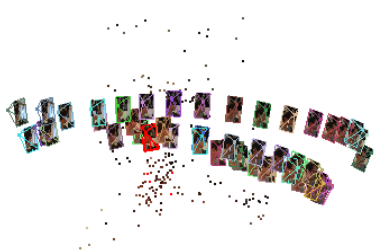
Figure 6. Imaging geometry of the first test case. Images were taken from varying perspectives, establishing good imaging geometry.